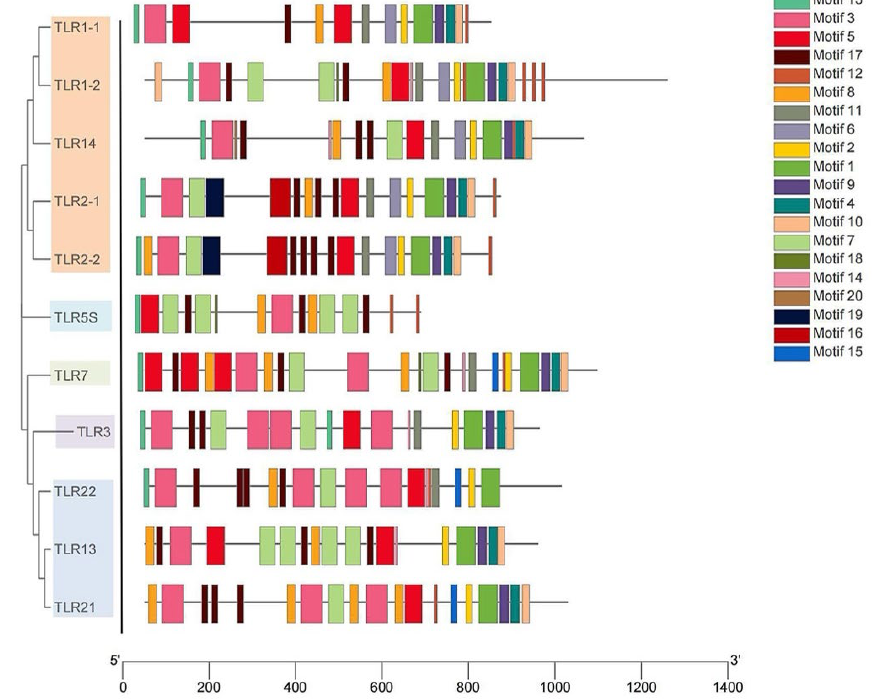
Figure 5. Conserved motifs analysis of TLR genes in marbled rockfish .